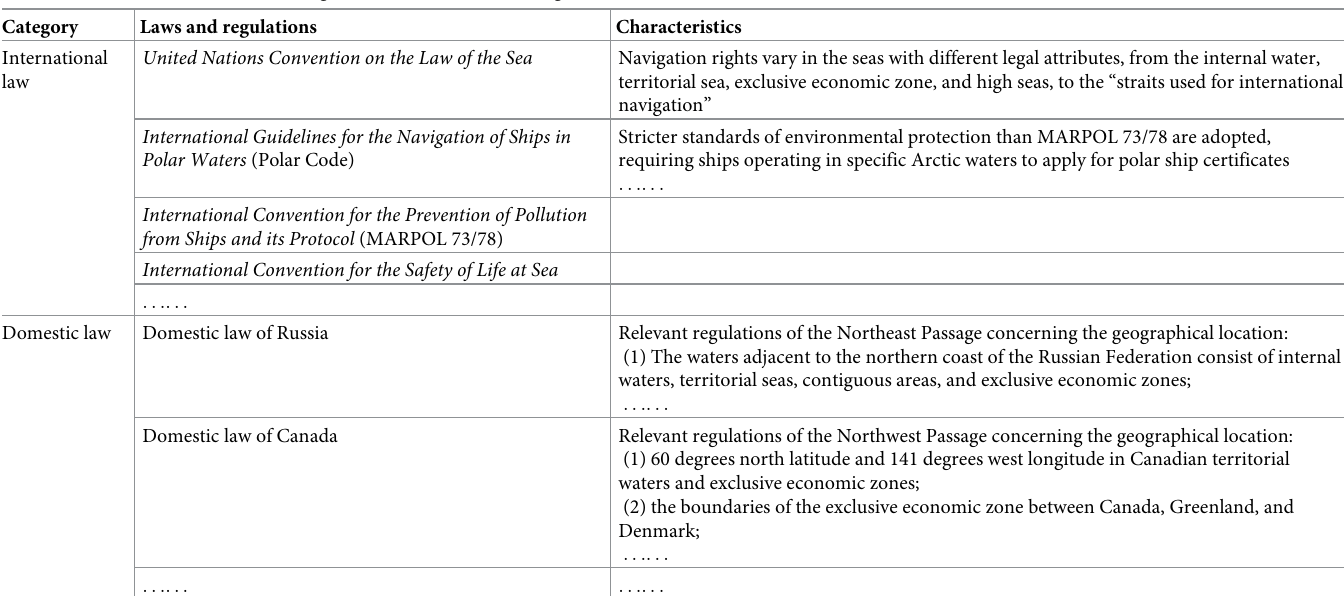
Table 3. Characteristics of laws and regulations in the Arctic